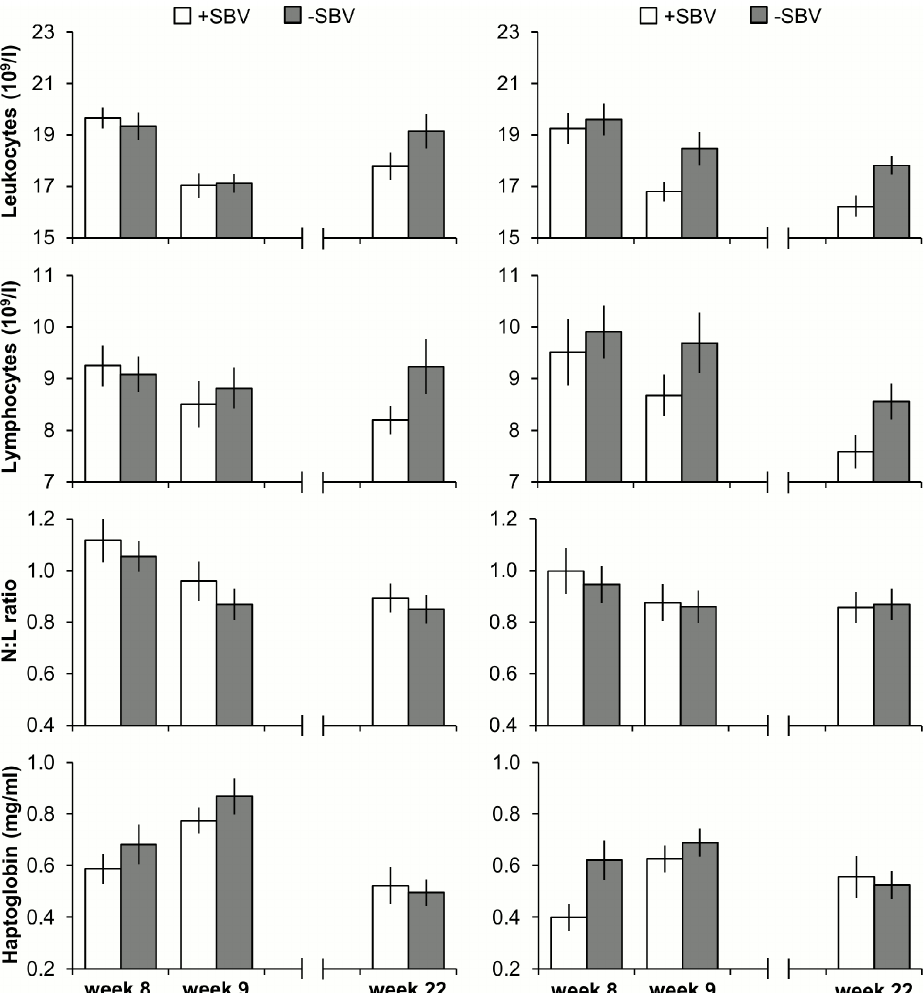
Figure 3. Means and SEM of leukocytes, lymphocytes, N:L ratio and haptoglobin. The concentrations of leukocytes (panels A and B), lymphocytes (panels C and D), the neutrophil to lymphocyte ratio (N:L ratio) (panels E and F), and haptoglobin concentrations (panels G and H) of pigs that have an estimated relative positive genetic effect ( + SBV) or negative genetic effect ( 2 SBV) on the growth of their pen mates in barren and enriched housing measured before a 24 h regrouping test at 8 weeks of age, after the regrouping test at 9 weeks of age and at 22 weeks of age. Significance of effects of housing and SBV is given in the text.